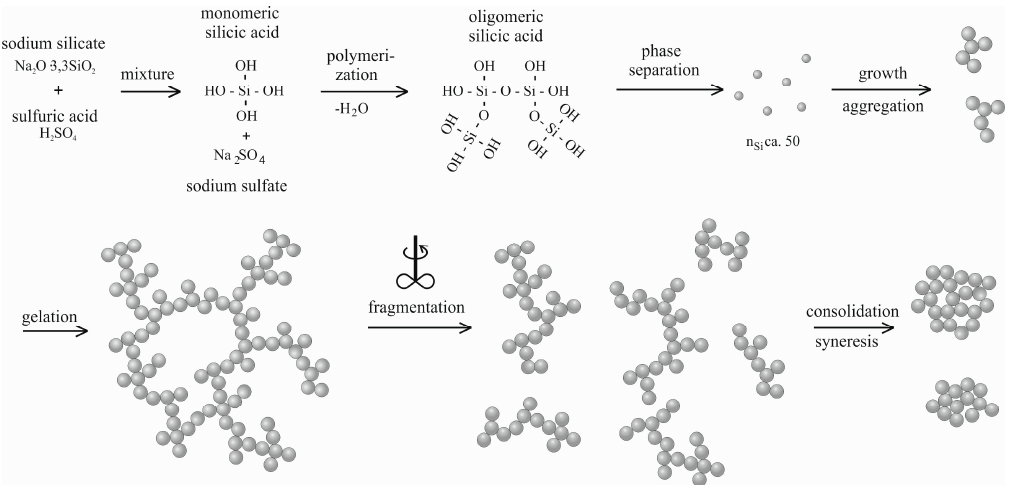
Figure 1. Mechanisms of silica precipitation (after Schlomach [3]).